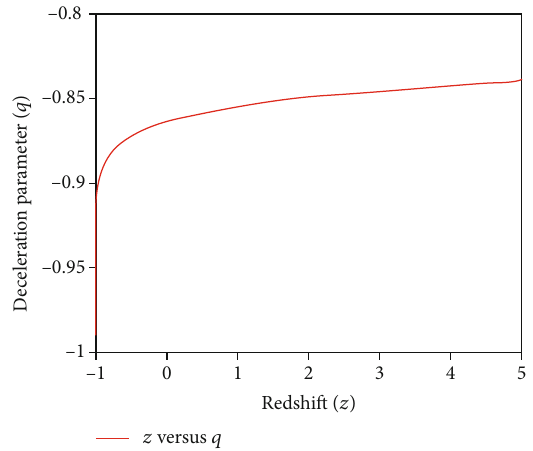
Figure 2: Deceleration parameter evolution in redshift for constants l = 1 : 5 , n = 2 , and k = 0 : 5 .